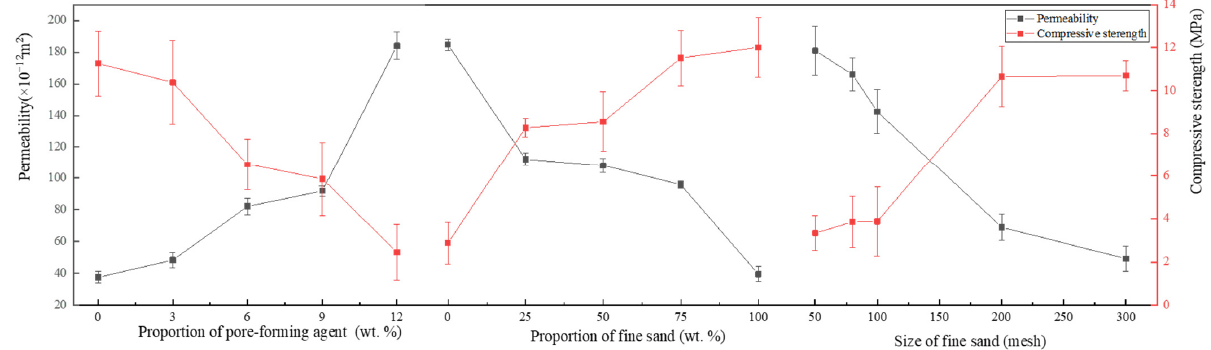
Figure 4. Effects of the proportion of pore-forming agent, the proportion of fine sand and the size of fine sand on the permeability and compressive strength.